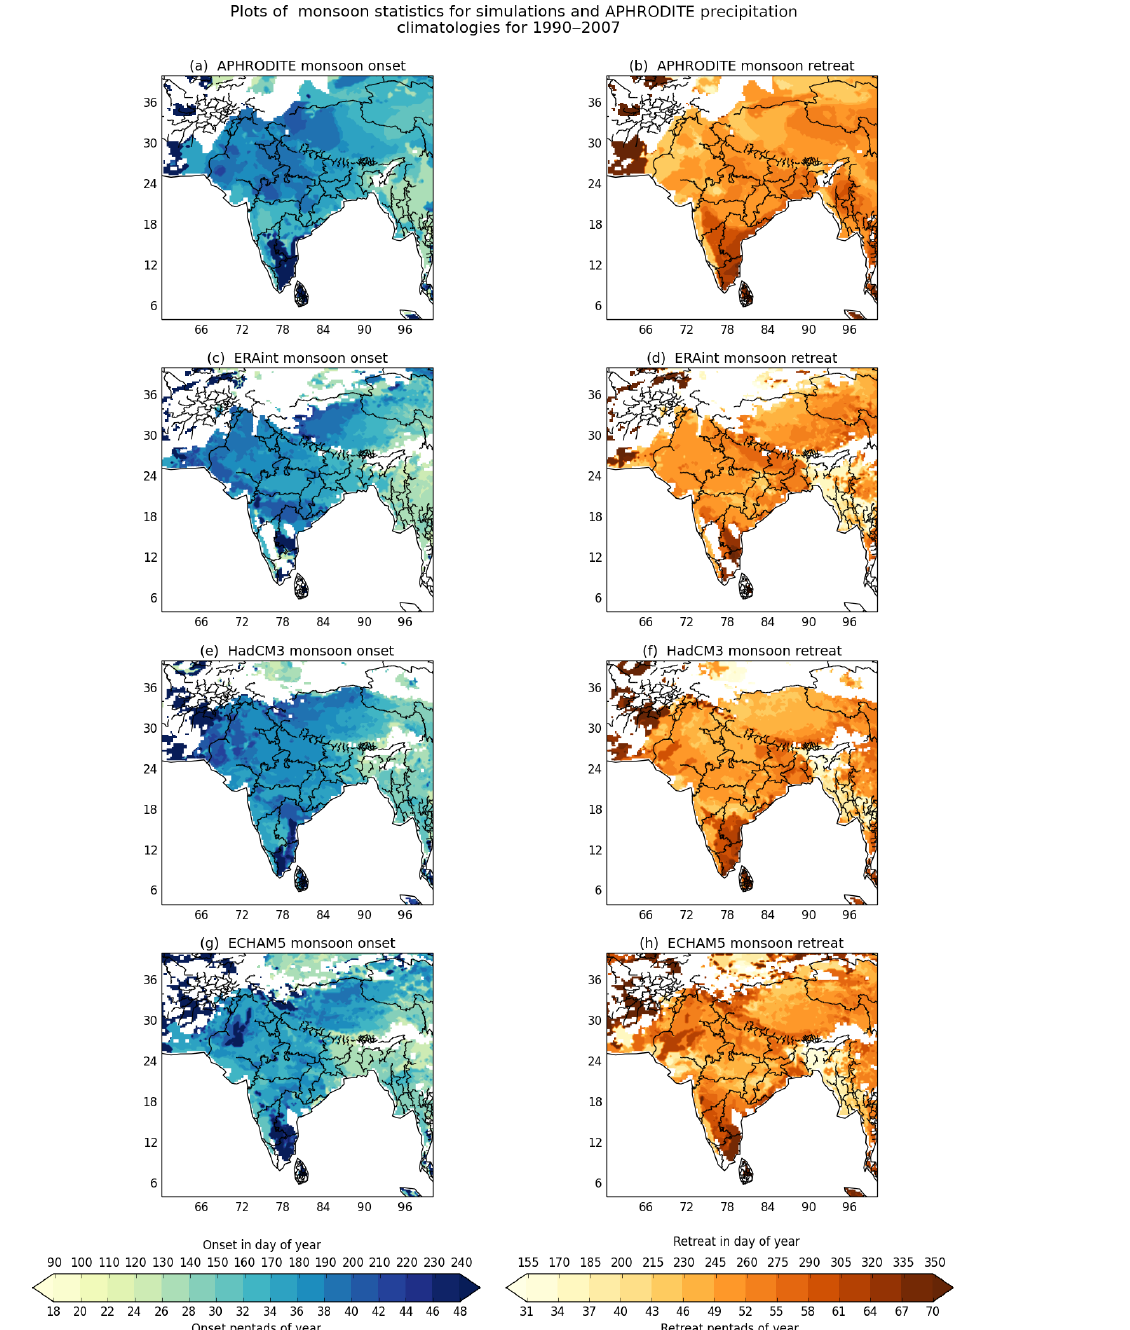
Figure 3. Plots of the 1990–2007 monsoon statistics; monsoon onset (a, c, e, g) and retreat (b, d, f, h) . The APHRODITE precipitation observations ( a and b ) are shown and the three model simulations, ERA-Interim ( c and d ), HadCM3 ( e and f ), and ECHAM5 ( g and h ), are calculated using the NPPI metric. White areas are the regions where the model precipitation exceeds the threshold, indicating the start of the monsoon at the initial pentad; this does not imply early monsoon but more likely a model bias in the precipitation at this